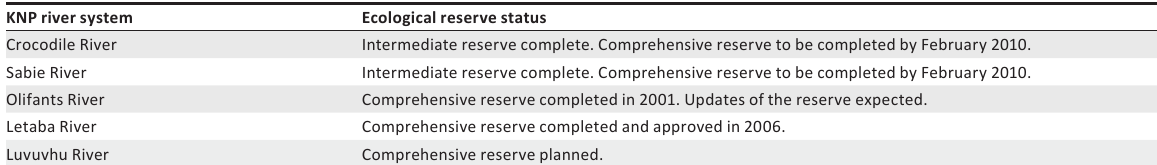
FIGURE 6 (Continues...): Recommended re-structuring related to the river-associated objectives. TABLE 6: Status of the Ecological Reserve studies for major rivers of the Kruger National Park.